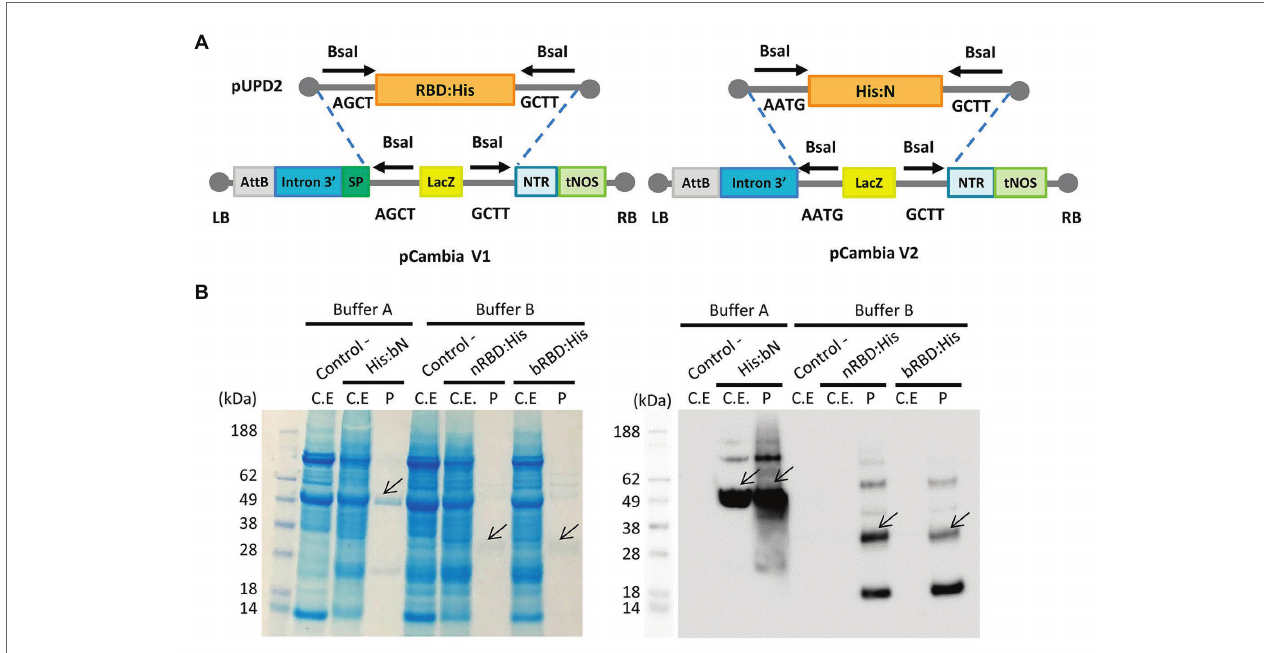
FIGURE 3 | SARS-CoV-2 RBD and N proteins expression in N. benthamiana agroinfiltrated leaves. (A) Schematic representation of the pUPD2 and 3 ' module vectors generated for antigen production. (B) Coomassie stained SDS-PAGE (left) and Western blot (right) of crude extracts from non-infiltrated N. benthamiana leaves (Control), leaves infiltrated with viral vectors for the expression of nRBD:His (n stands for native sequence), His:bN and bRBD:His (b stands for N. benthamiana codon optimized sequence) and the corresponding purified